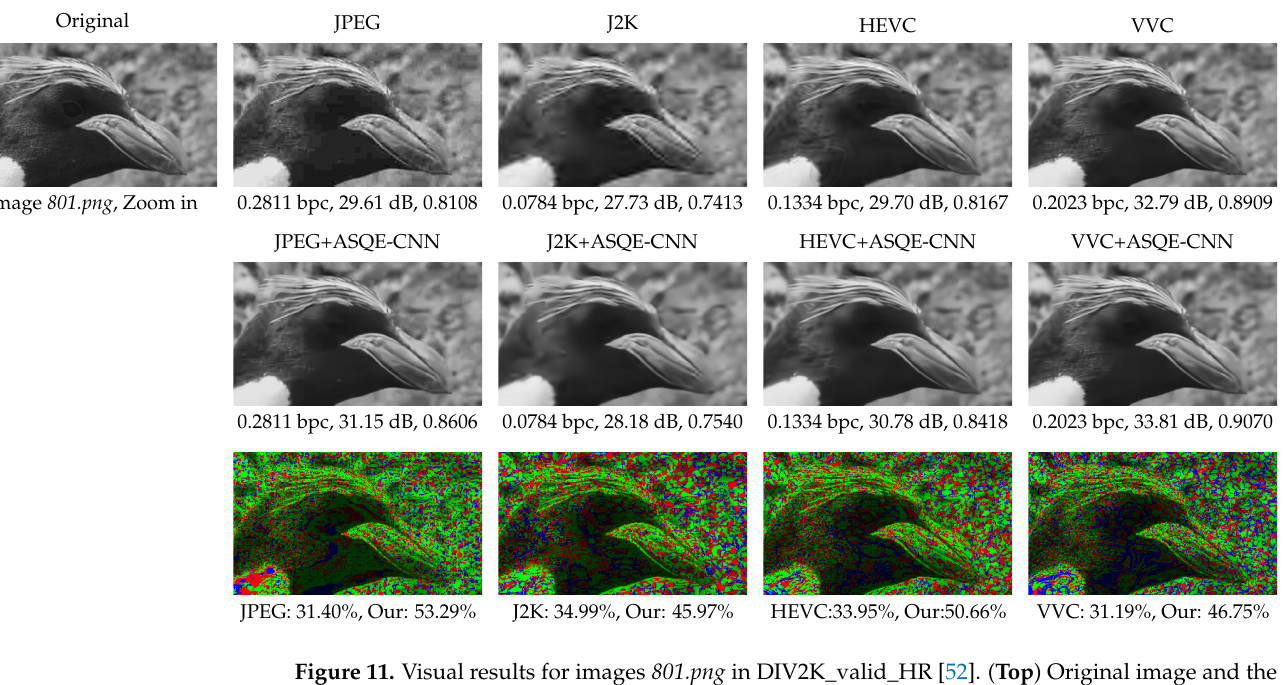
Figure 11. Visual results for images 801.png in DIV2K_valid_HR [52]. ( Top ) Original image and the results of traditional codecs. ( Middle ) Quality enhancement results corresponding to each codec. ( Bottom ) Pseudo-colored image comparison. Green marks the pixel positions where ASQE-CNN achieves better performance. Blue marks the pixel positions where the methods have the same performance. Red marks the pixel positions where traditional codecs achieves better